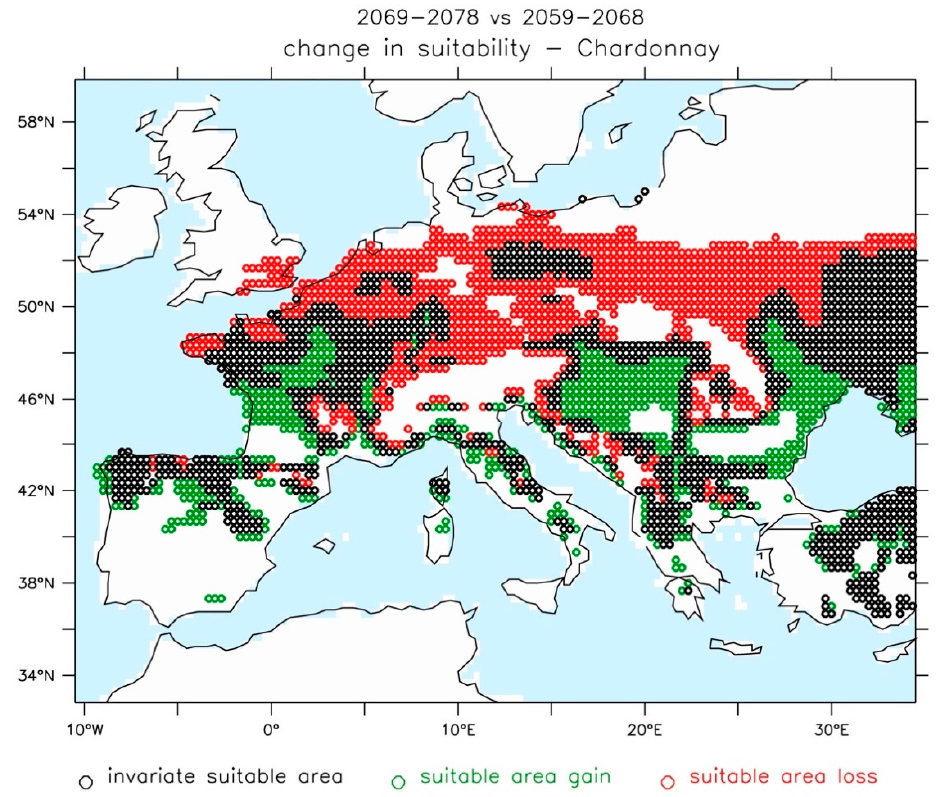
Figure 7. Anomaly in climatic suitability for premium wine production between the decade 2069– 2078 and the decade 2059–2068 as simulated by the downscaled CSIRO-Mk3-6-0 model. Climatic suitability is based on the definition we introduced in Methods and Material. Over a decade, a location is assumed to be suitable when the climatic conditions are satisfied for at least 70% of the years. Results are based on the ensemble mean of the three different phenological models. Black circles indicate locations for which climatic conditions are suitable for both the 2059–2068 and the 2069–2078 periods. Green (red) circles indicate sites where climatic conditions are suitable for the decade